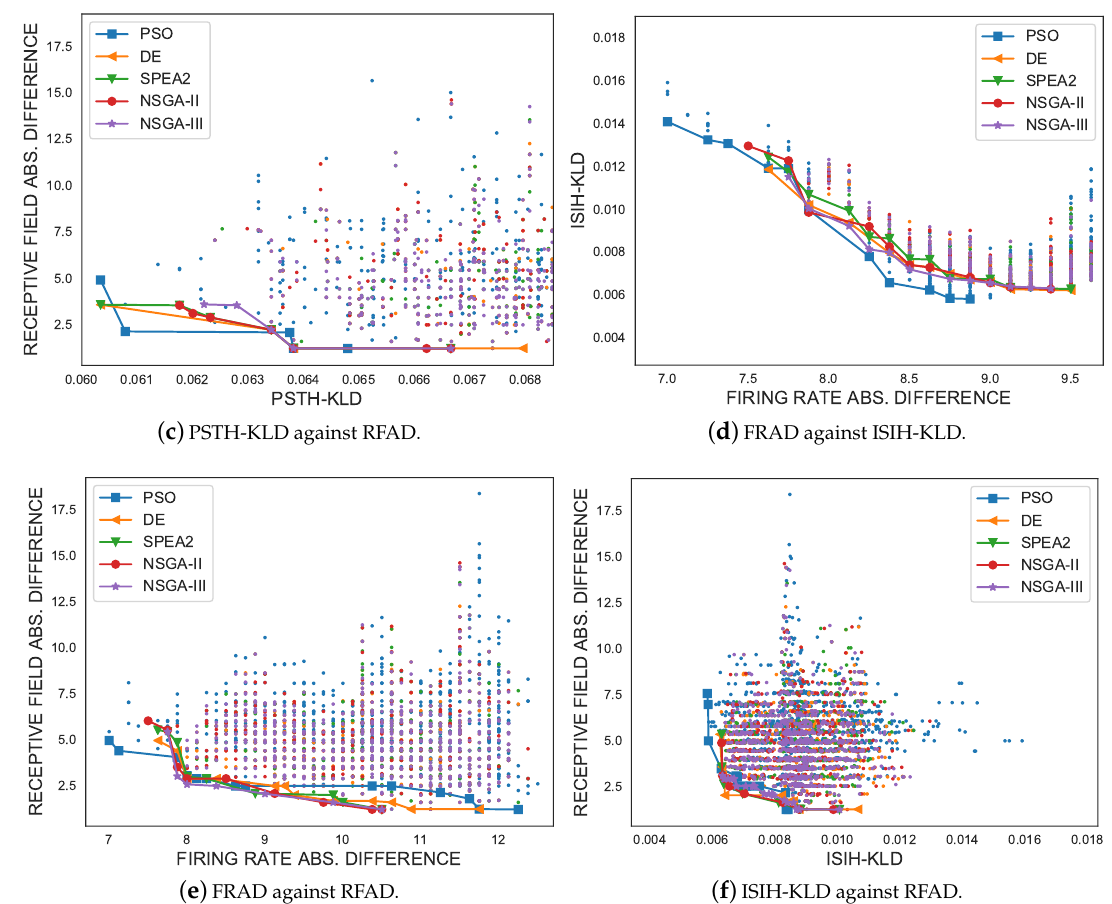
Figure 6. Multi-objective graphs and Pareto-optimal sets of all multi-objective optimisation metaheuristics facing each pair of criteria. ( a ) The PSTH-KLD metric against the Firing Rate Absolute Difference (FRAD) metric with their Pareto fronts; ( b ) The PSTH-KLD metric against the ISIH-KLD metric with their Pareto fronts; ( c ) The PSTH-KLD metric against the RFAD metric with their Pareto fronts; ( d ) The FRAD metric against the ISIH-KLD metric with their Pareto fronts; ( e ) The FRAD metric against the RFAD metric with their Pareto fronts; ( f ) The ISIH-KLD metric against the RFAD metric with their Pareto